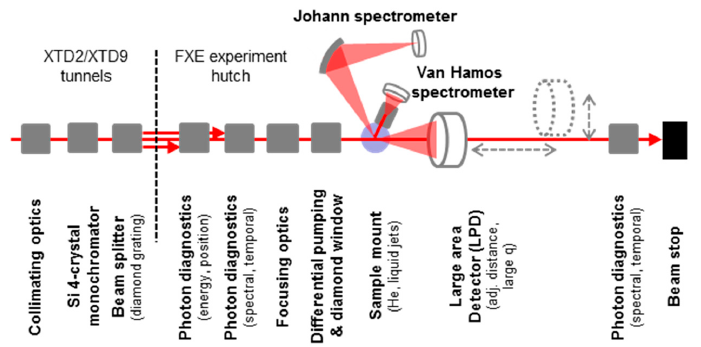
Figure 5. Overview schematic of the FXE scientific instrument at the SASE1 FEL beamline. The sketch indicates major instrumentation items installed in the photon beam transport tunnel and experiment hutch. Not shown is the PP-laser instrumentation.